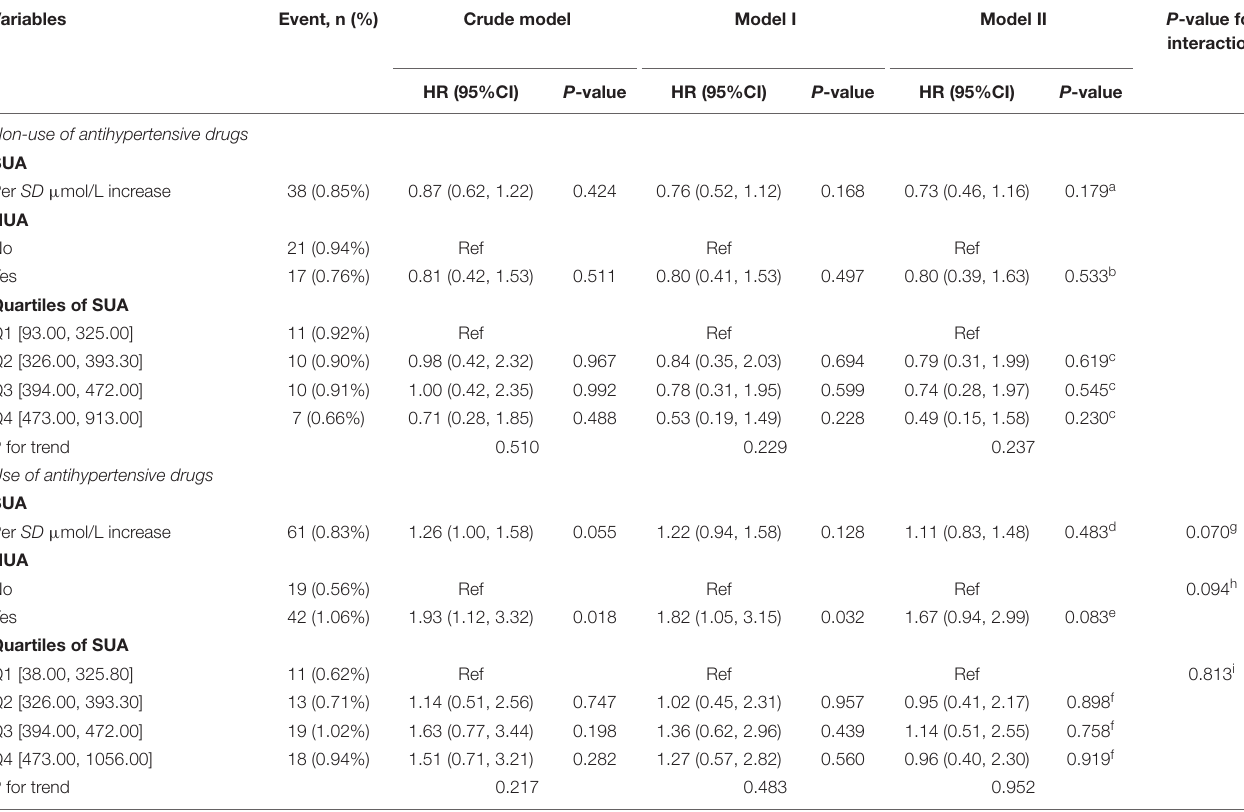
TABLE 7 | Hazard ratios of serum uric acid level categories for total first stroke events by antihypertensive drugs usage in different models. Variables Event, n (%) Crude model Model I Model